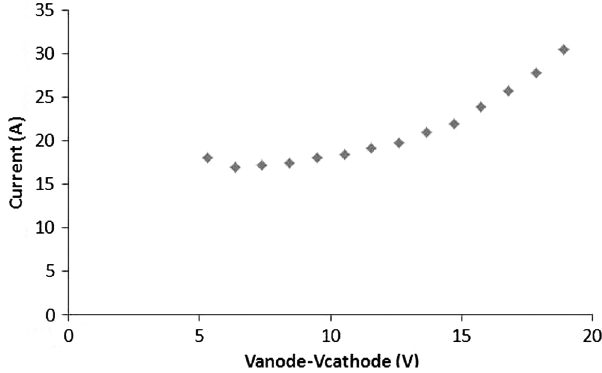
FIG. 15. I(V) curve obtained on single-cell